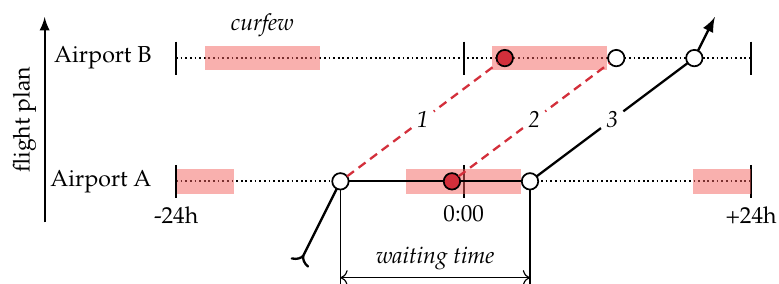
Figure 7. The waiting mechanism during